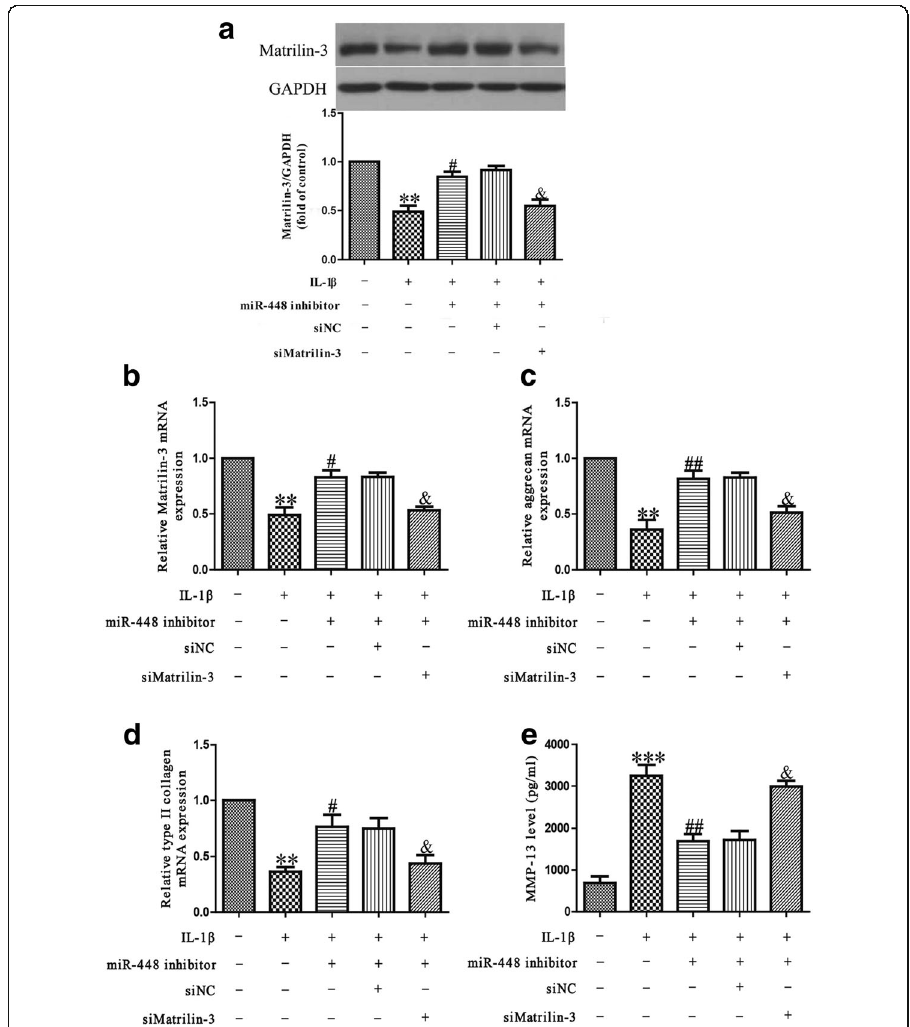
Fig. 5 Matrilin-3 was involved in the effects of miR-448 on IL-1 β -induced cartilage degradation in chondrocytes. Chondrocytes were transfected with either miR-448 inhibitor or si-matrilin-3, and then treated with 5 ng/ml IL-1 β for 24 h. a , b The mRNA and protein levels of matrilin-3 were respectively determined using quantitative real-time PCR and western blot. The mRNA levels of aggrecan ( c ) and type II collagen ( d ) were determined using quantitative real-time PCR. GAPDH was detected as a loading control. e The expression level of secreted MMP-13 protein was determined by ELISA. All data are presented as means ± SEM, n =4. ** p <0.01, *** p < 0.001 vs. control; # p <0.05, ## p <0.01 vs. vehicle + IL-1 β ; & p <0.05 vs. IL-1 β +miR-448